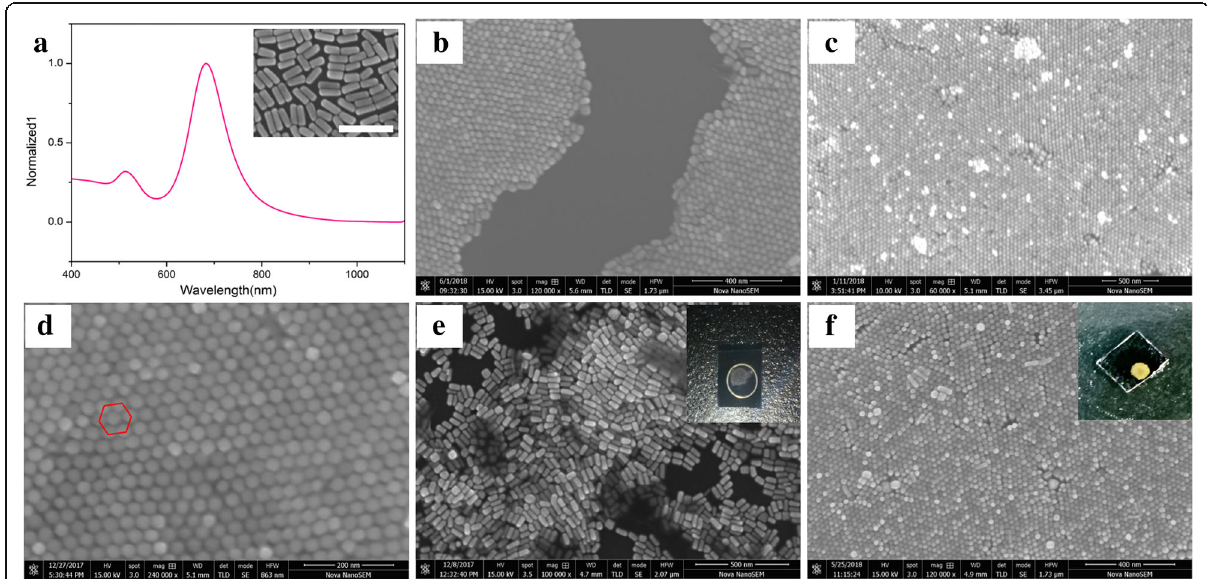
Fig. 2 a The ultraviolet-visible absorption spectrum of GNR. b – d The typical SEM images of the GNR vertical arrays. e , f Correspond to the SEM images of coffee rings and coffee stain